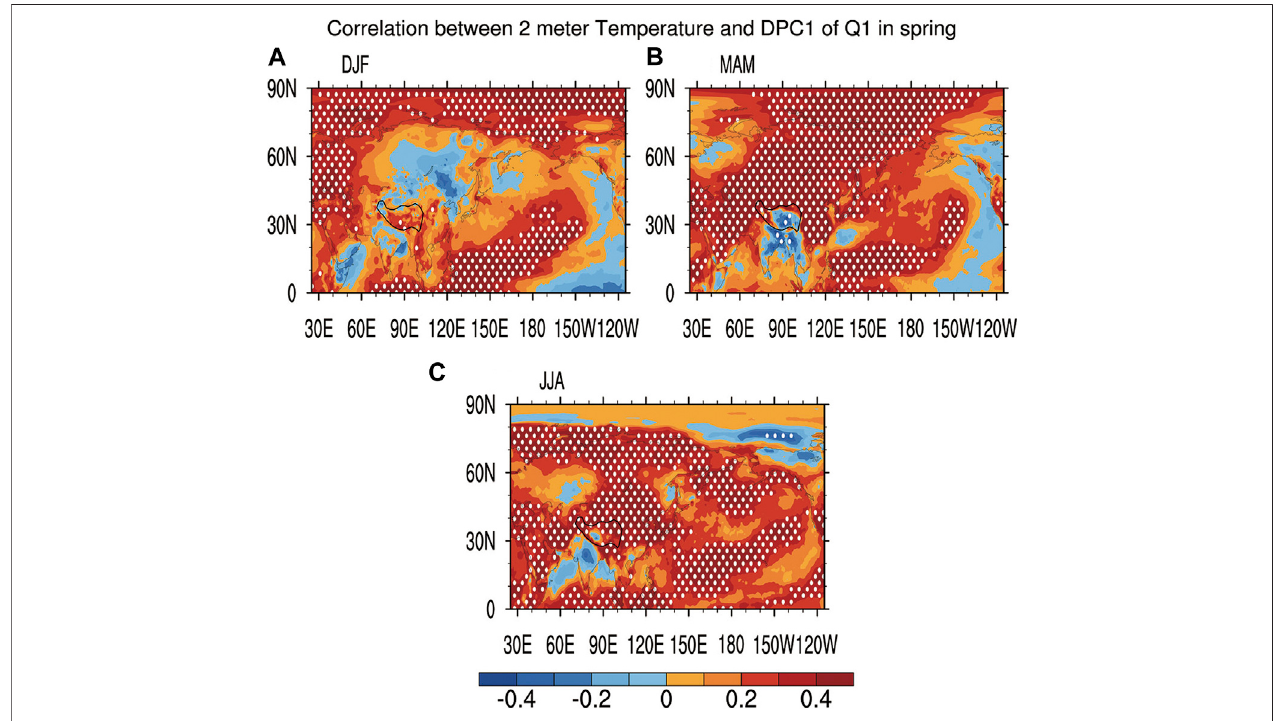
FIGURE 7 | Distribution of the correlation coef fi cients between DPC1 and the 2 m air temperature in the time period 1979 – 2020 in (A) previous winter, (B) spring and (C) summer. The white dots indicate statistical signi fi cance at the 95% con fi dence level.